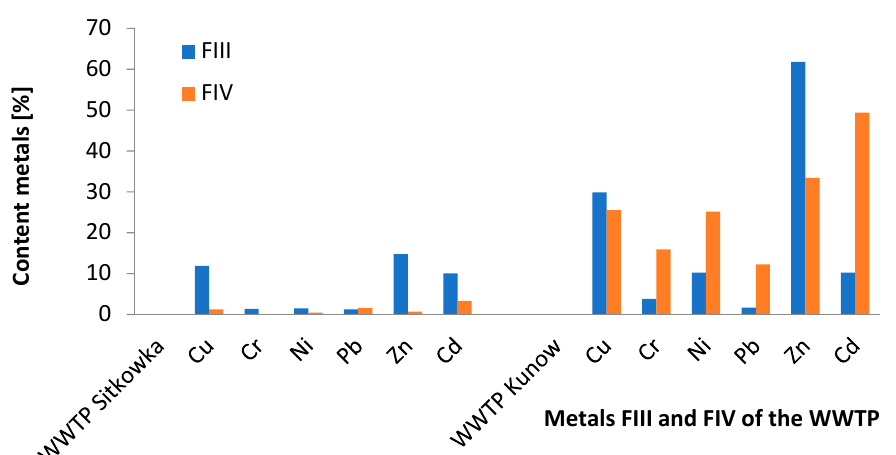
Figure 3. Percentage % of metals in the FI and FII fractions of the sludge of WWTP Sitkowka and WWTP Kunow in relation to the Polish standard [9].